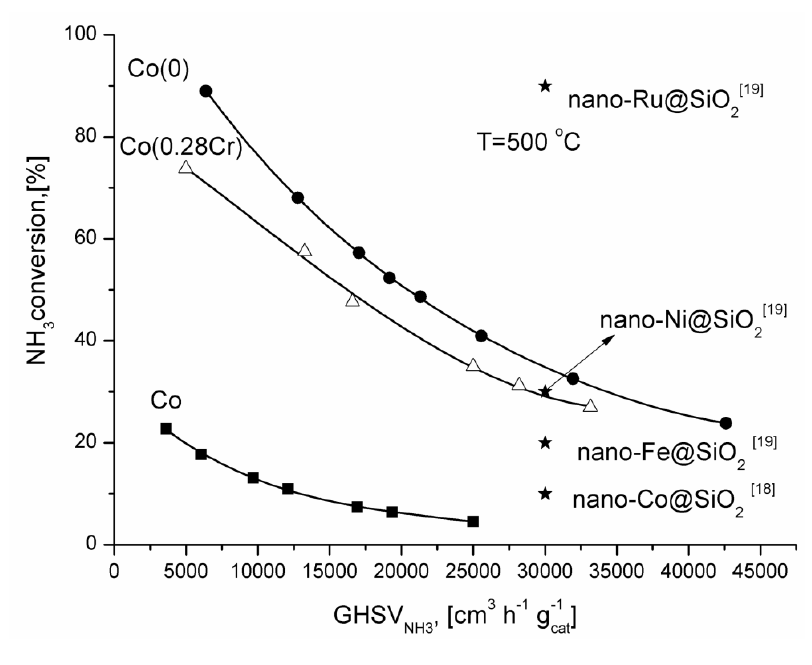
Figure 4. Dependence of the ammonia conversion degree at 500 °C as a function of